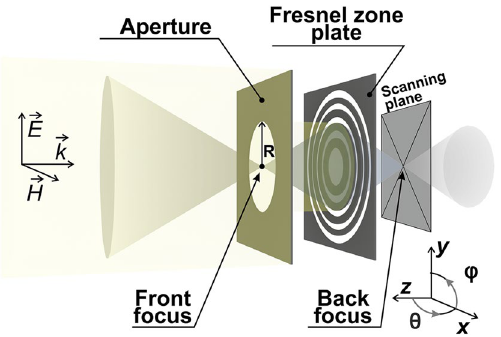
Figure 1. System’s layout—an aperture in front of the Fresnel zone